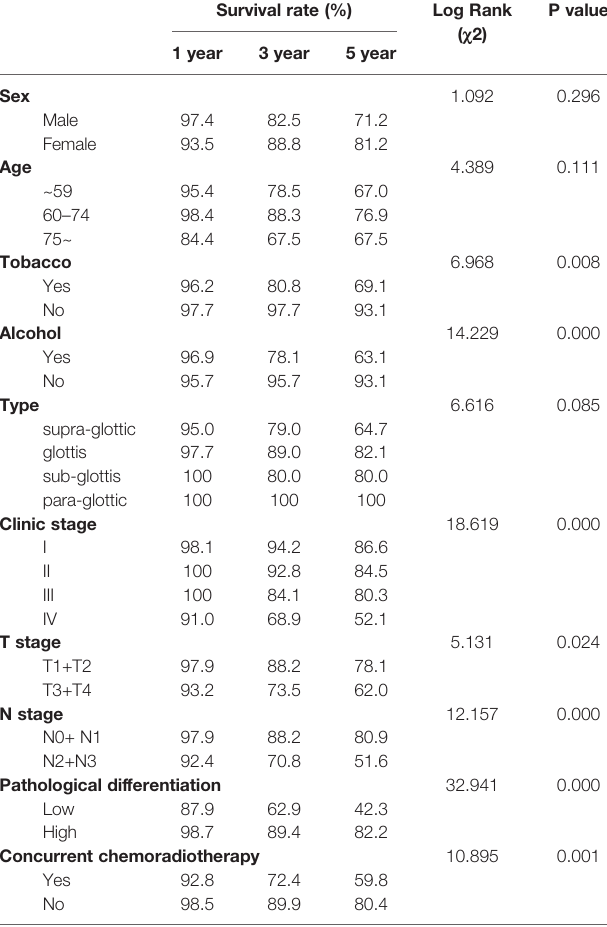
TABLE 4 | Progression free survival rates and univariable analysis of Kaplan-Meier. Survival rate (%)